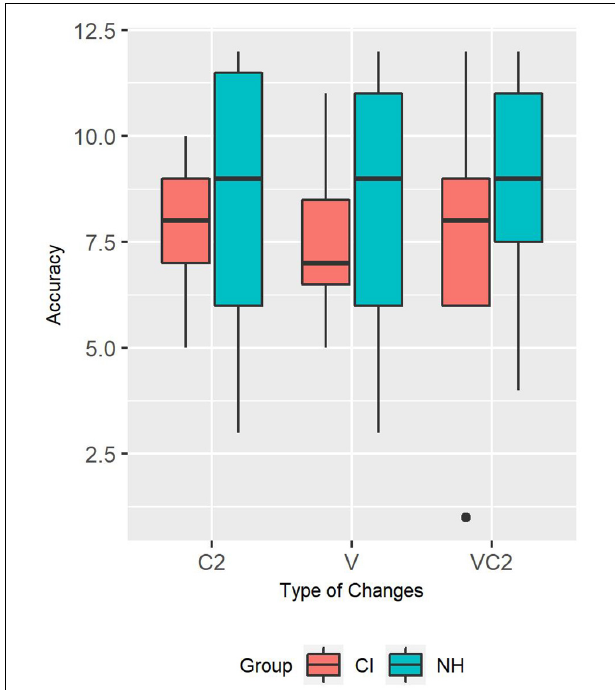
FIGURE 3 | Accuracy for trials with a C2, V, and VC2 change (by